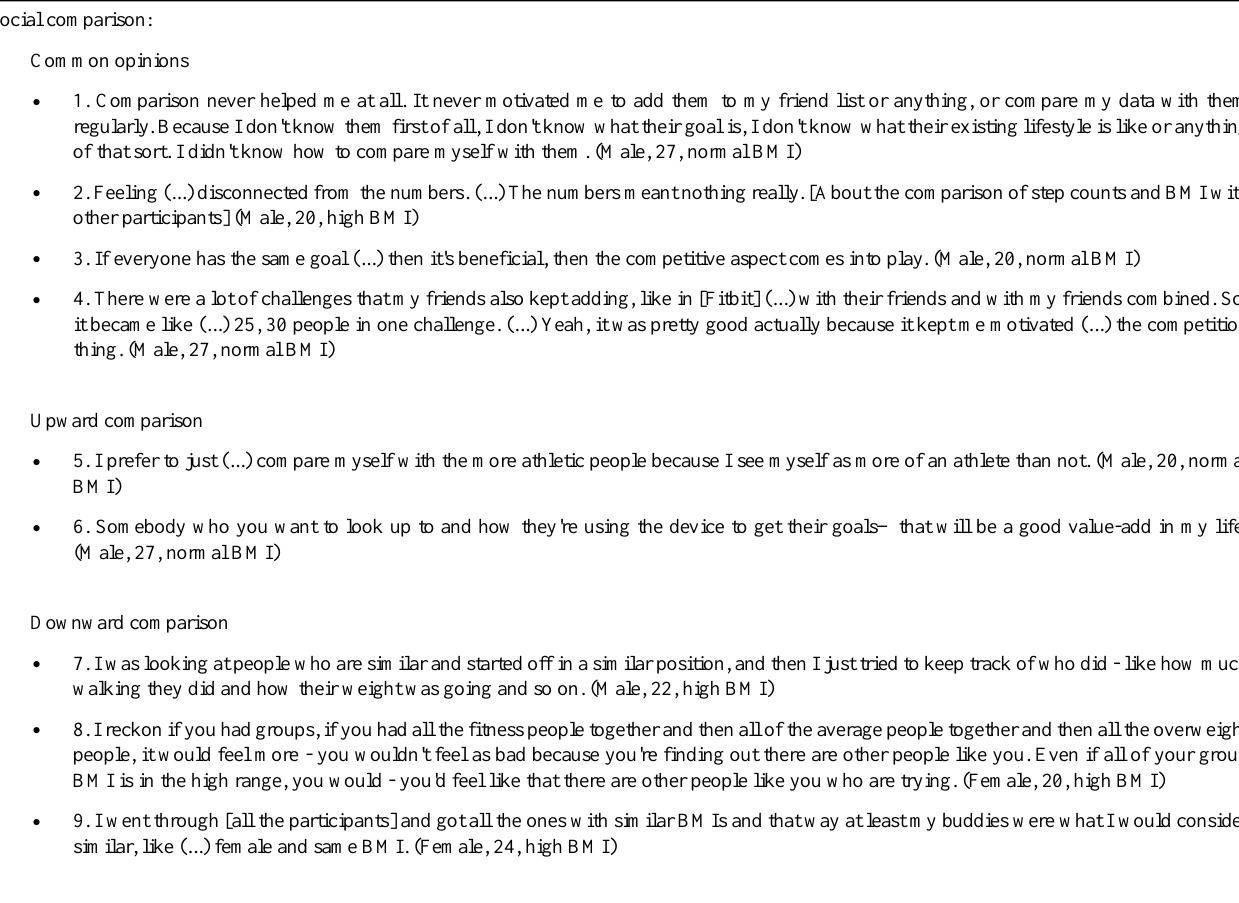
Textbox 1. Illustrative quotes for social aspects related to weight management and physical